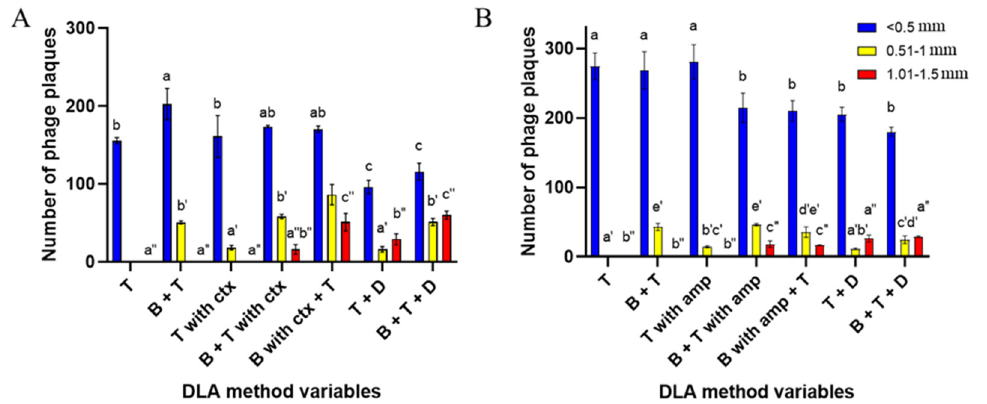
Figure 3. The number of phage plaques per plate divided into diameter ranges, depending on the DLA method variable with the addition of ( A ) cefotaxime or ( B ) ampicillin. Diameter ranges were established as follows: <0.5 mm—small, standard T4 plaques (blue bars), 0.51–1 mm—medium, standard T4 plaques (yellow bars), 1.01–1.5 mm—large, strong PAS-indicating plaques (red bars). Top agar was marked as “T”, bottom agar as “B”, antibiotic disk as “D”, cefotaxime and ampicillin as “ctx” and “amp”, respectively. Vertical bars indicate means ± SD. a, b, c, …, a’, b’, c’, …, and a’’, b’’, c’’, …,—means sharing the same superscript are not significantly different from each other at p ≤ 0.05.